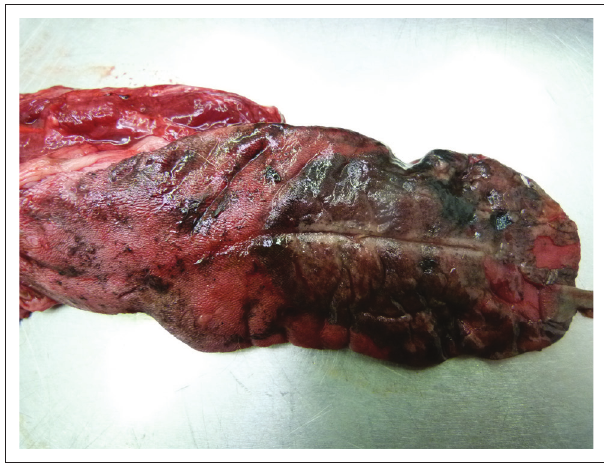
FIGURE 1: Tongue of paraquat-poisoned dog showing activated charcoal blackening, necrosis, dorsal tip epithelial sloughing, ulcerations and erosions.